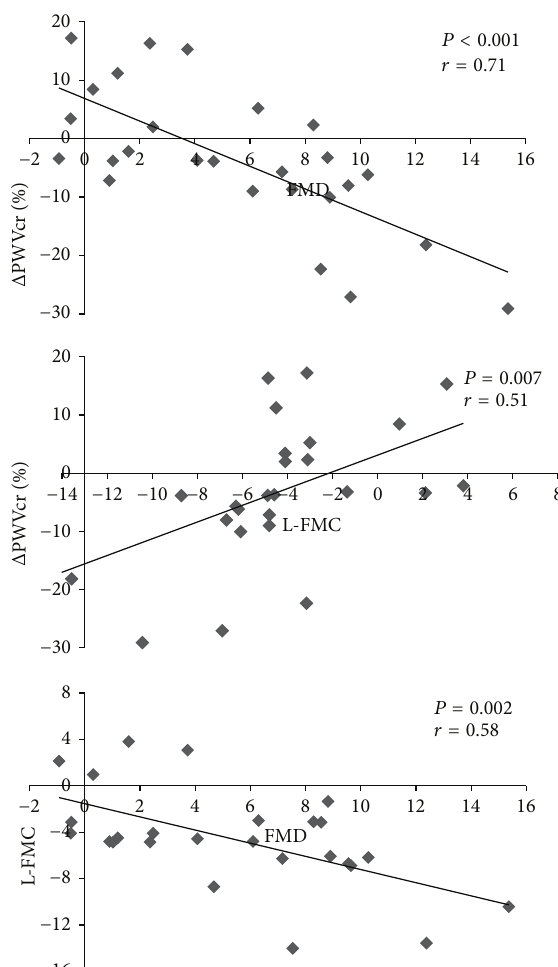
Figure 3: Correlation analysis between EF parameters. FMD: flow-mediated dilation; L-FMC: low-flow-mediated constriction; Δ PWVcr%: percentage of change in carotid-to-radial pulse wave